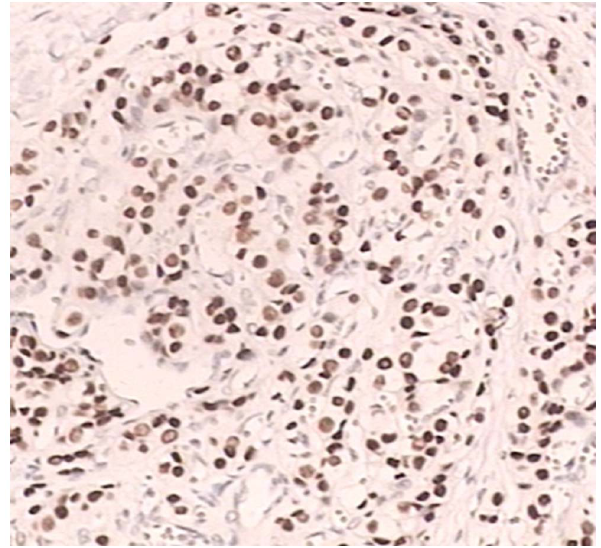
Figure 1. TTF-1 positive expression in adenocarcinoma cell (IHC 6